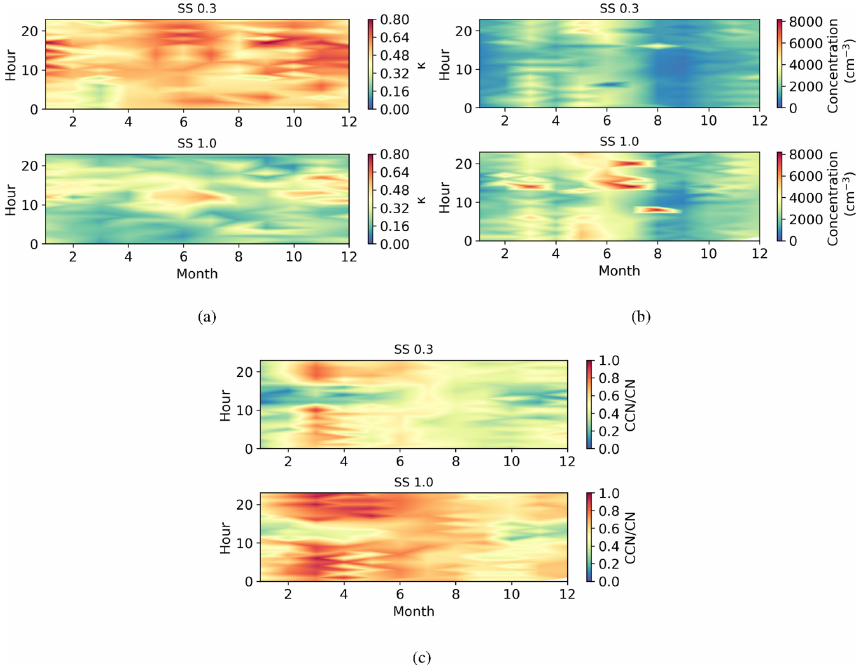
Figure 6. Seasonally diurnal contour plots of (a) κ parameter, (b) CCN number concentration (cm − 3 ), and (c) activation fraction (CCN/CN) in different supersaturations. Hourly median values have been